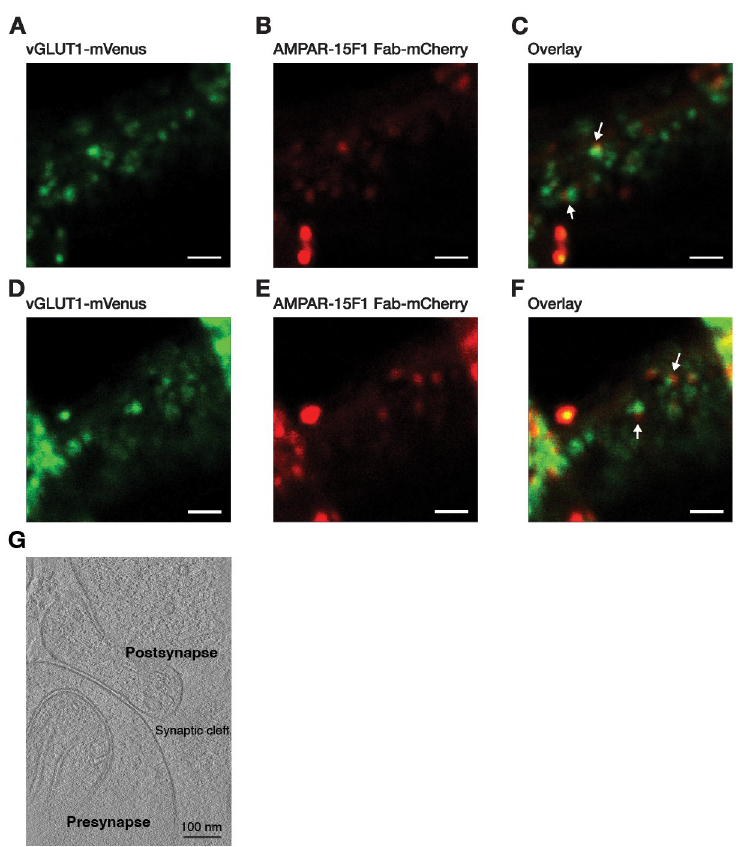
Fig 6. Cryo-LSM images of glutamatergic synaptosomes in two cryo-FIB-milled lamellae, (A-C) lamella 1 and (D-F) lamella 2. Fluorescence signal from green, red and both green & red channels corresponding to (A) vGLUT1-mVenus, (B) AMPAR-15F1 Fab-mCherry and (C) overlay of vGLUT1-mVenus and AMPAR-15F1 Fab-mCherry, respectively. Glutamatergic synaptosomes are highlighted with white arrows. Scale bar: 5 μ m.